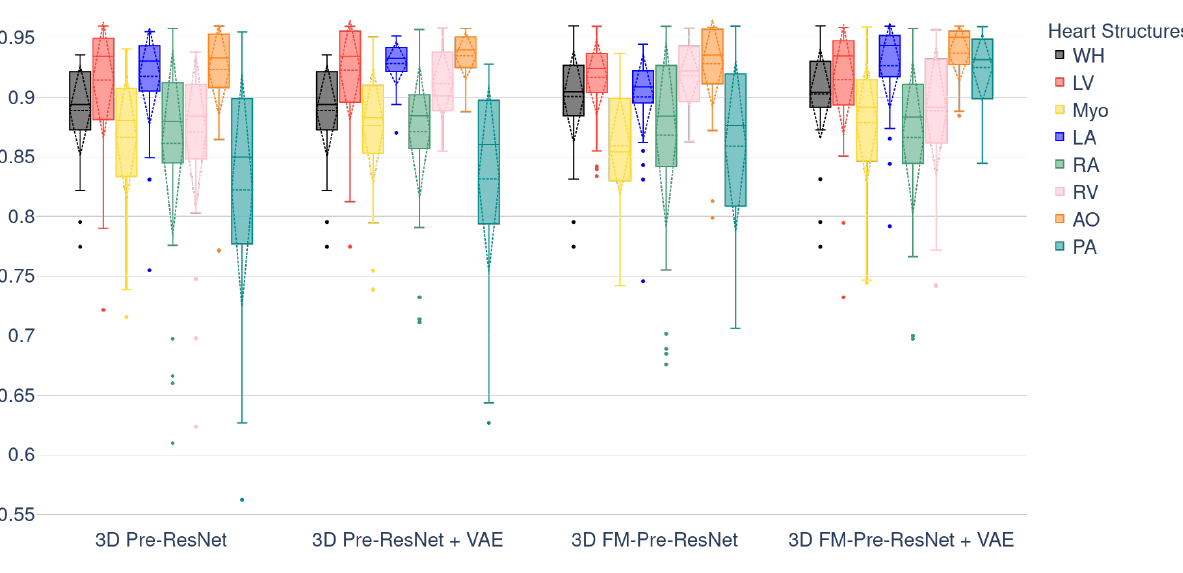
Figure 6. Boxplots showing the DSC dispersion for WH, LV, Myo, LA, RA, RV, AO, and PA using different segmentation networks on the MMWHS CT testing dataset. Boxplot illustrates interquartile range (bounds of box), mean (X inside a box), median (centerline), maximum and minimum values (whiskers), and outliers (circles outside whiskers).